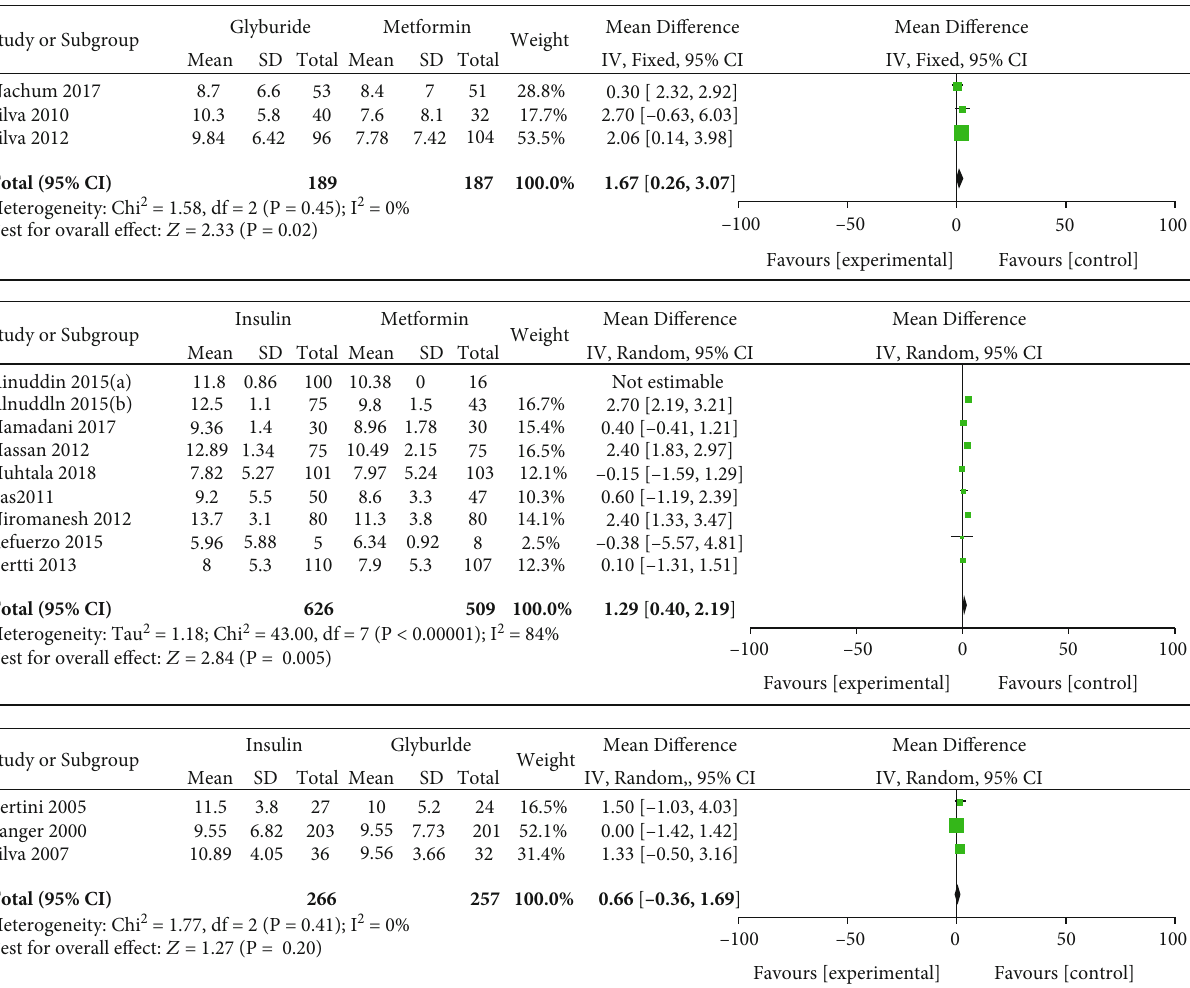
Figure 7: Gestational weight